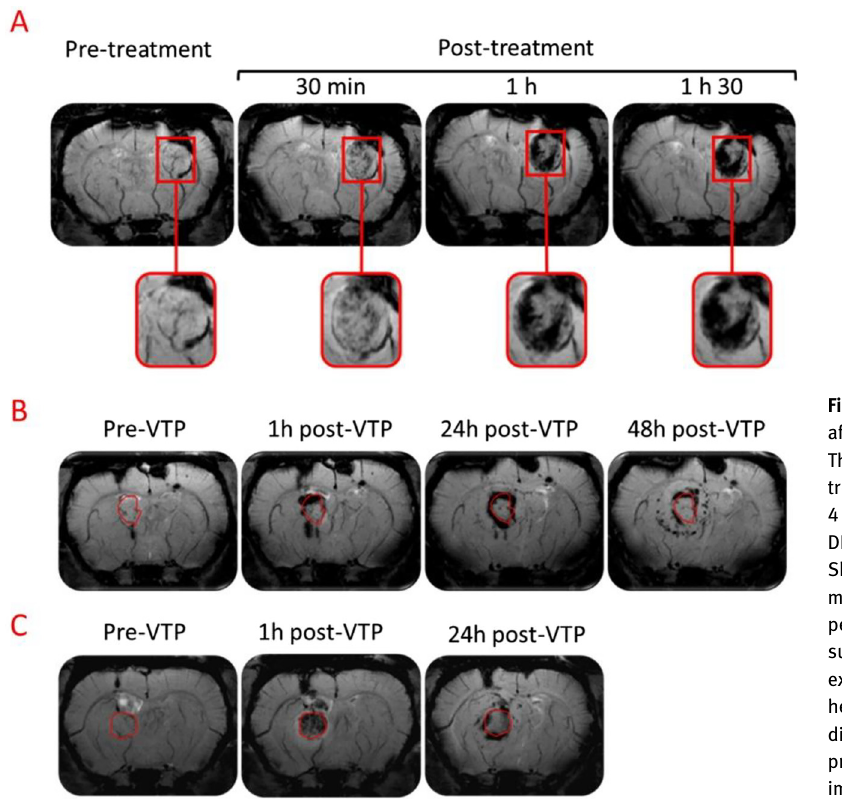
Figure 7: Formation of microhemorrhages after